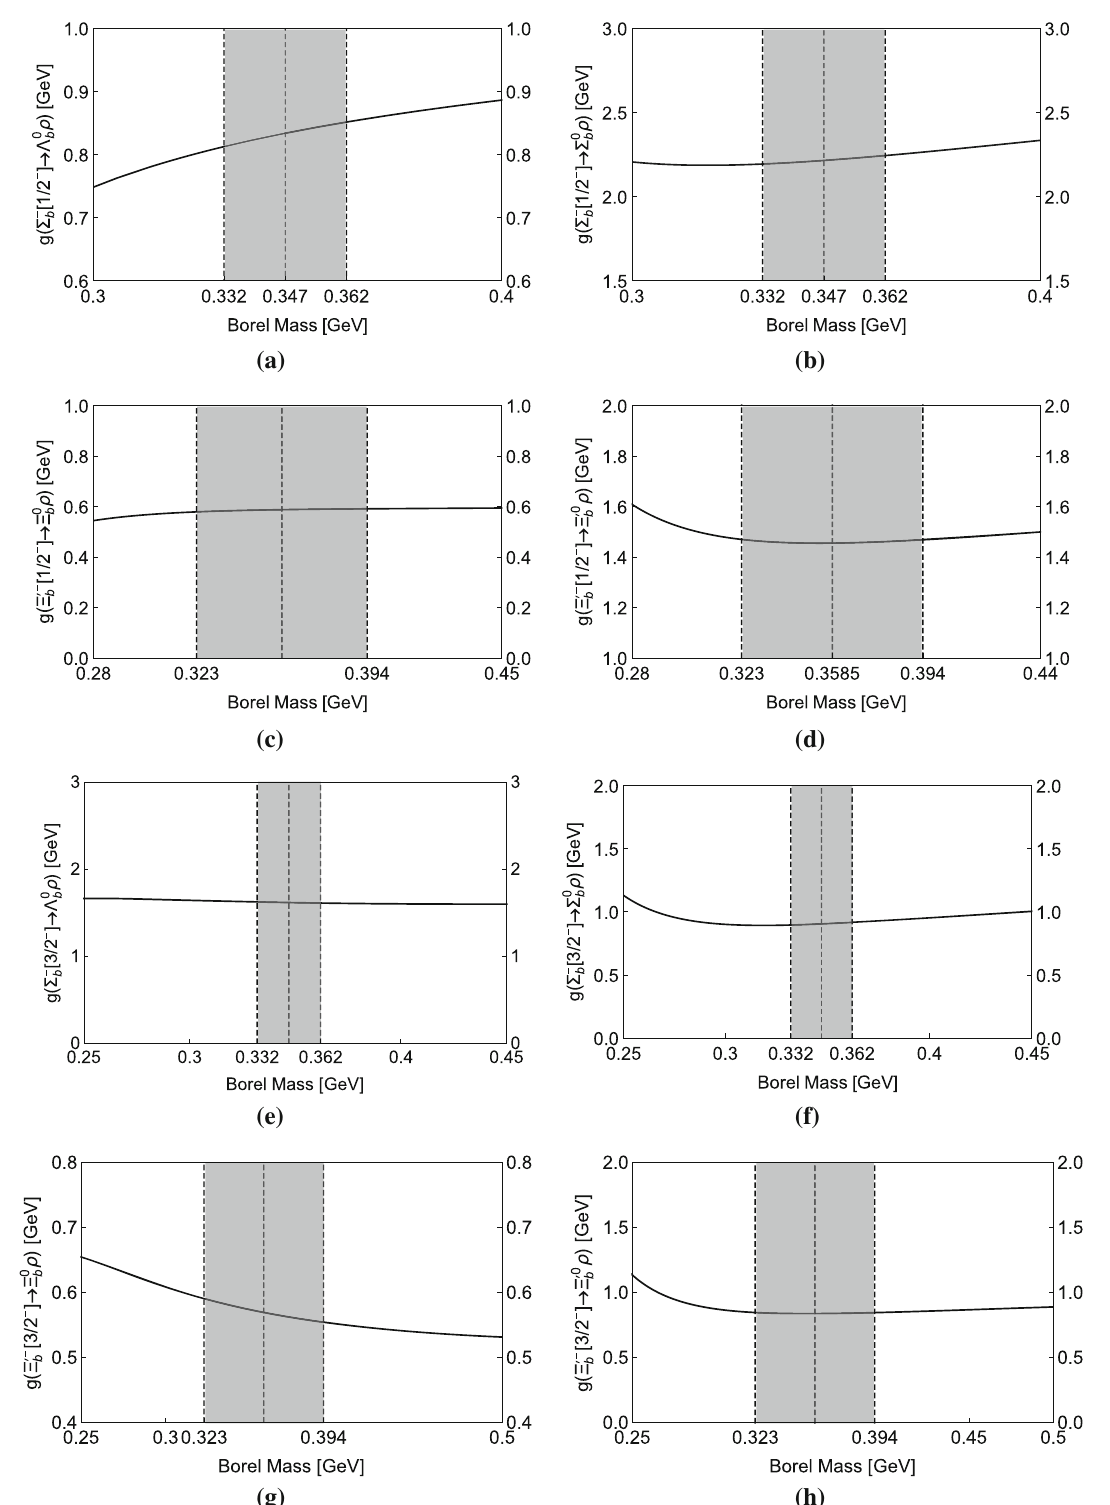
Fig. 4 The coupling constants a g